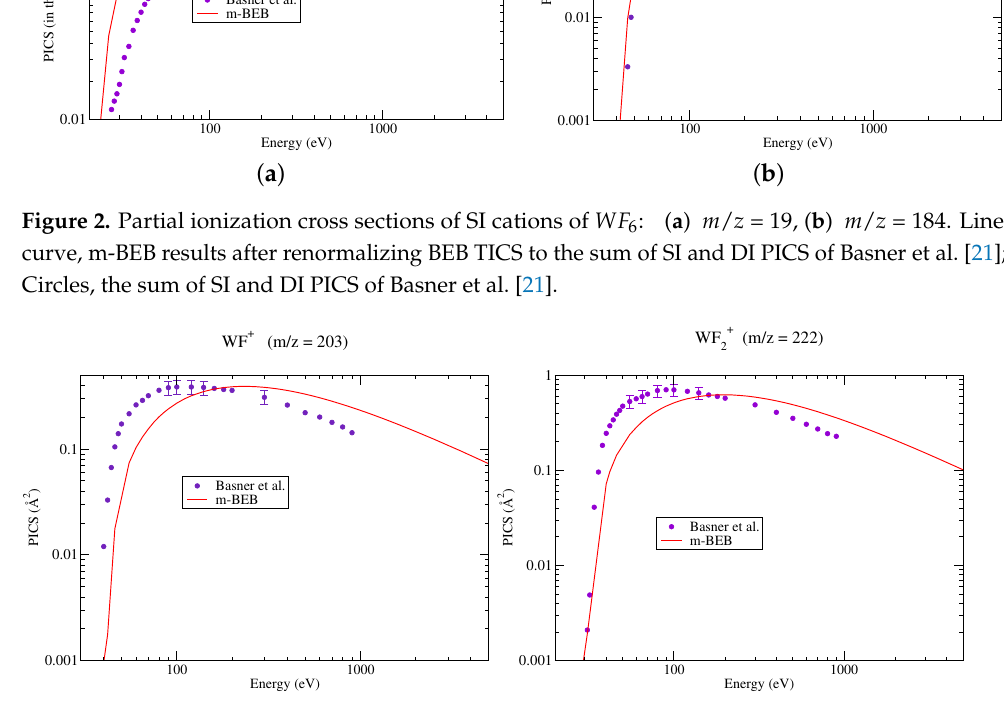
Figure 3. Partial ionization cross sections of SI cations of WF 6 for different m / z values. Line curve, m-BEB results; Circles, SI PICS of Basner et al.